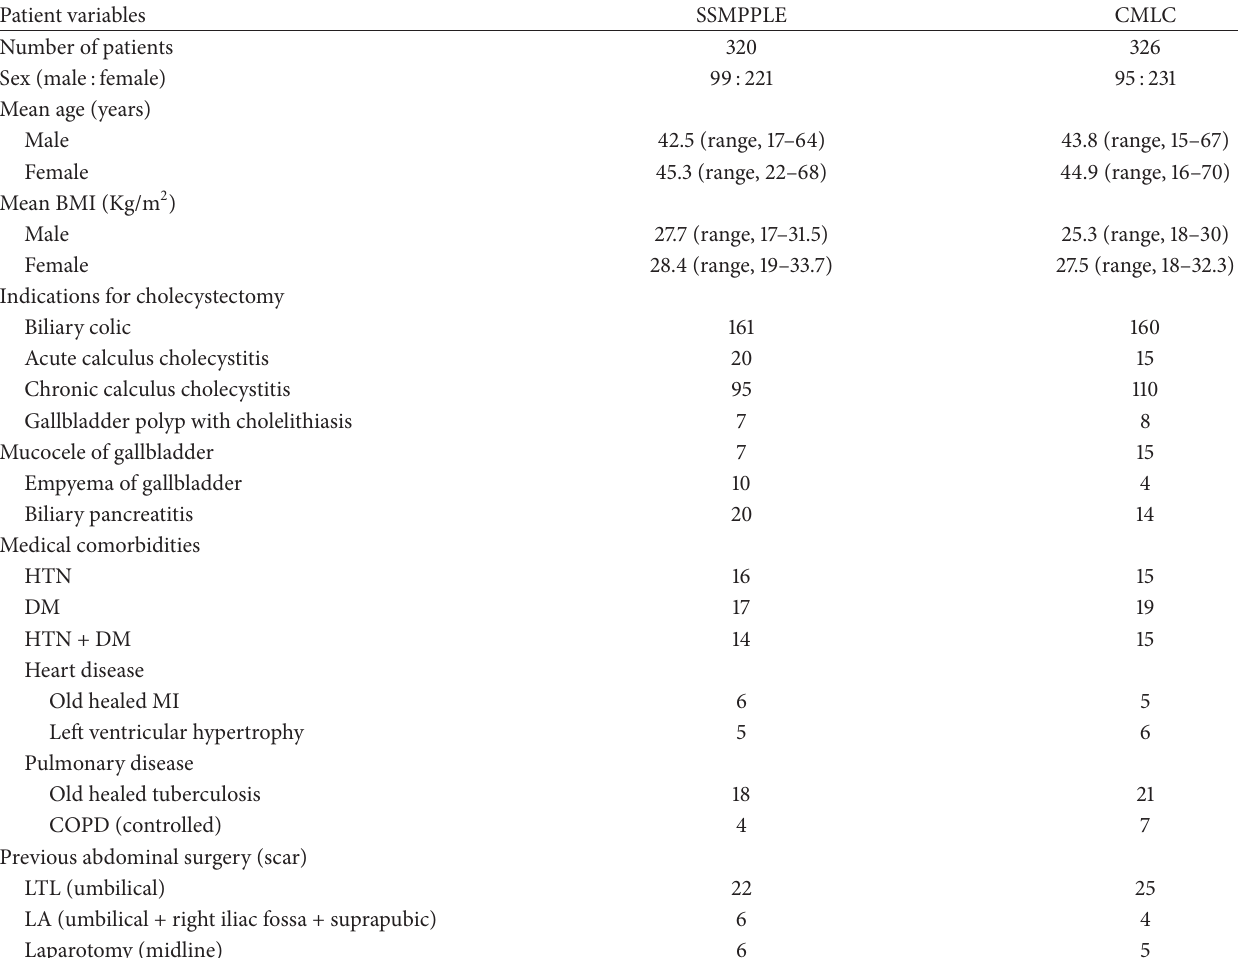
Table 1: Patient